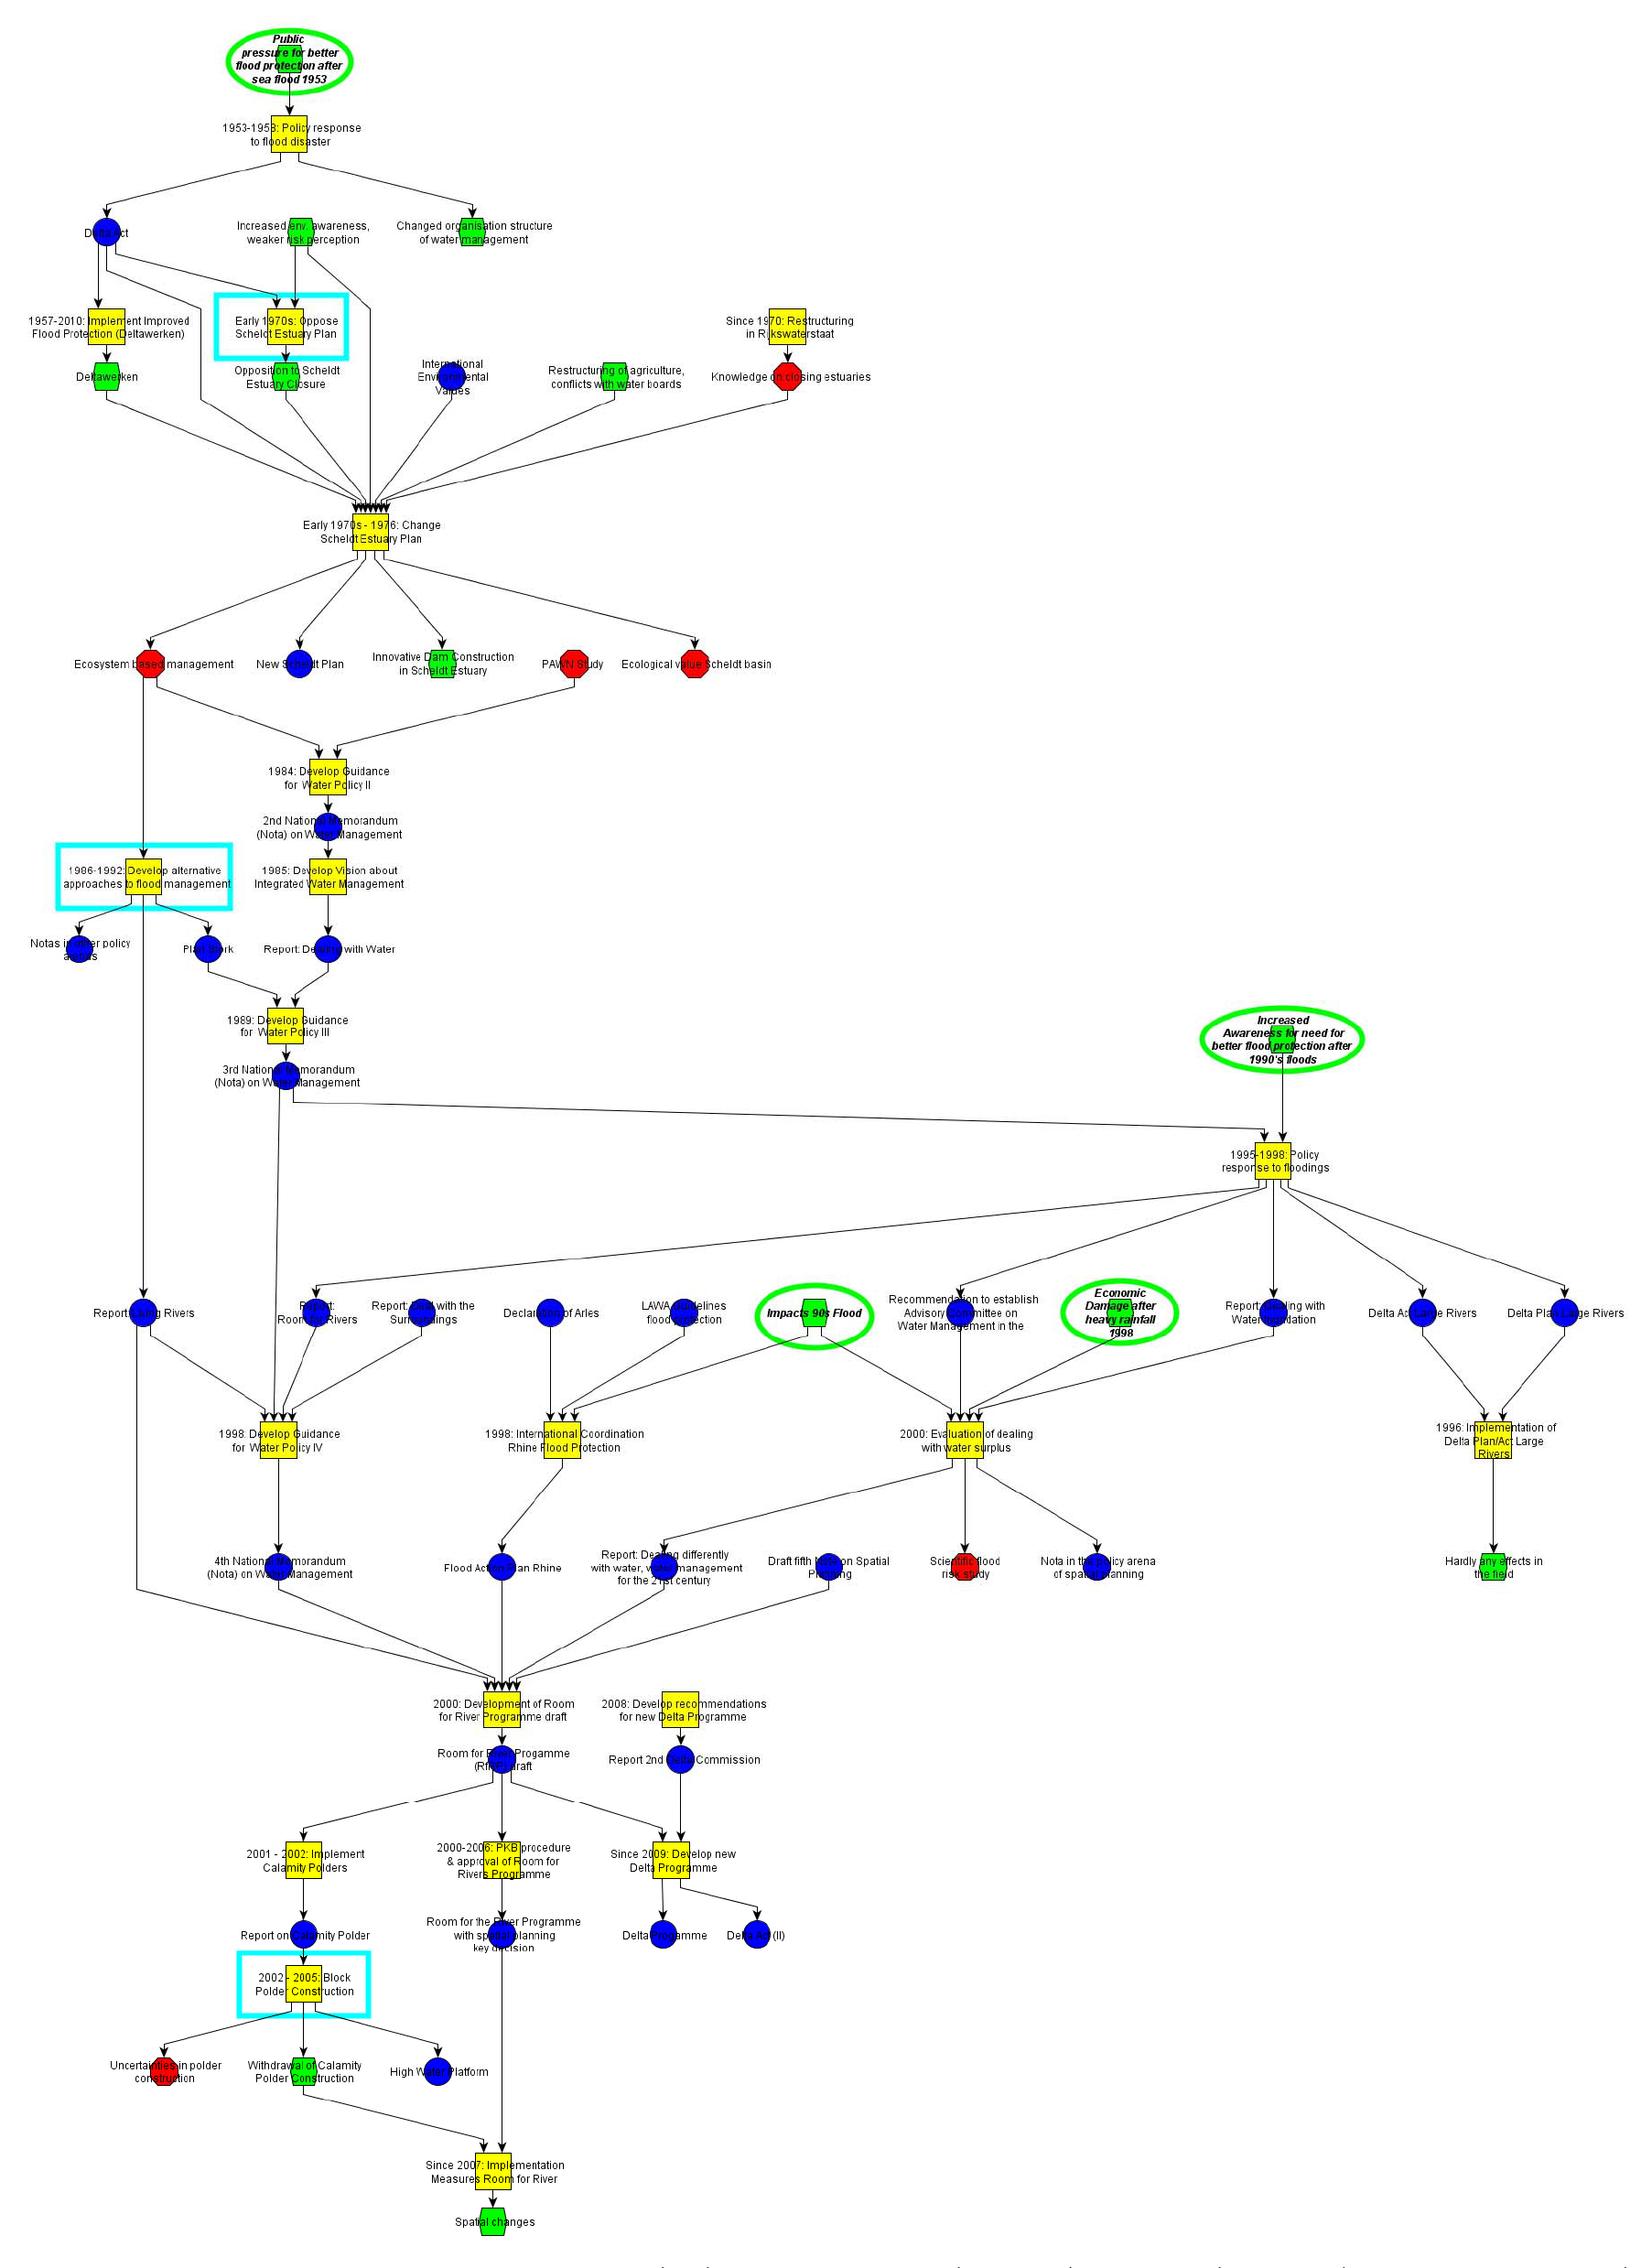
Figure A5. Rhine Netherlands: Network of action situations (ASs) linked by institutions (blue circle), knowledge (red octagon) or operational outcomes (green hexagon). Learning AS are marked by a turquois rectangle. Extreme events and their impacts on public perception and policy response are marked by a green